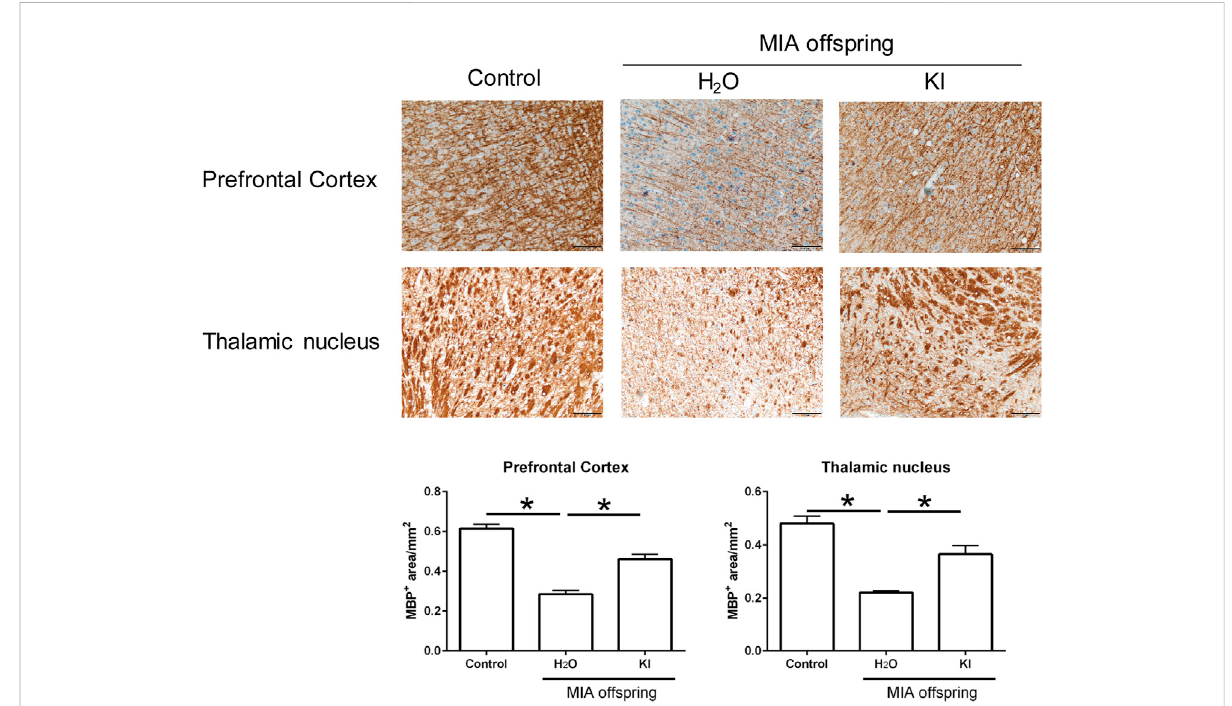
FIGURE 4 Amelioration of hypomyelination in maternal immune activation (MIA) offspring after oral KI Essence extract treatment. Myelin basic protein (MBP) expression levels in the prefrontal cortex and thalamic nucleus of control group, H 2 O-treated MIA offspring, and KI Essence extract – treated MIA offspring were detected through immunohistochemical staining. Quanti fi cation of MBP + area in the prefrontal cortex and thalamic nucleus is presented in the bar graph p p < 0.05; n = 3 for each group). All data are presented as means ± standard errors of means (scale bar: 100